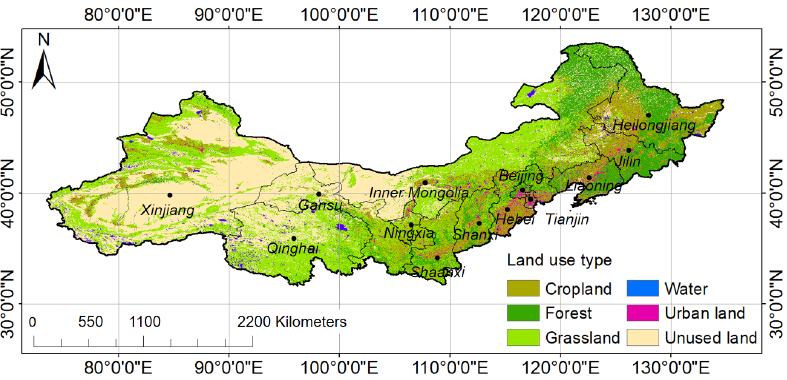
Figure 10. Land use map of northern